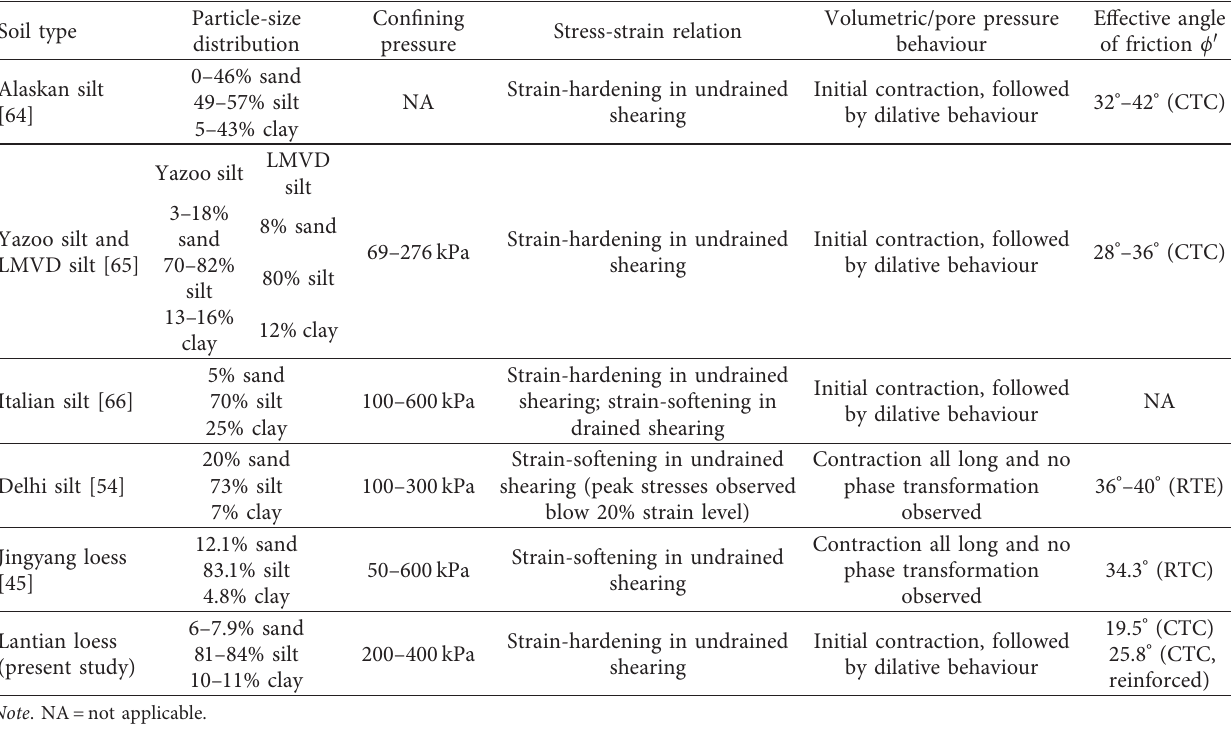
Table 3: Stress-strain-volume change and pore pressure comparison of remoulded silts under compression and extension tests.